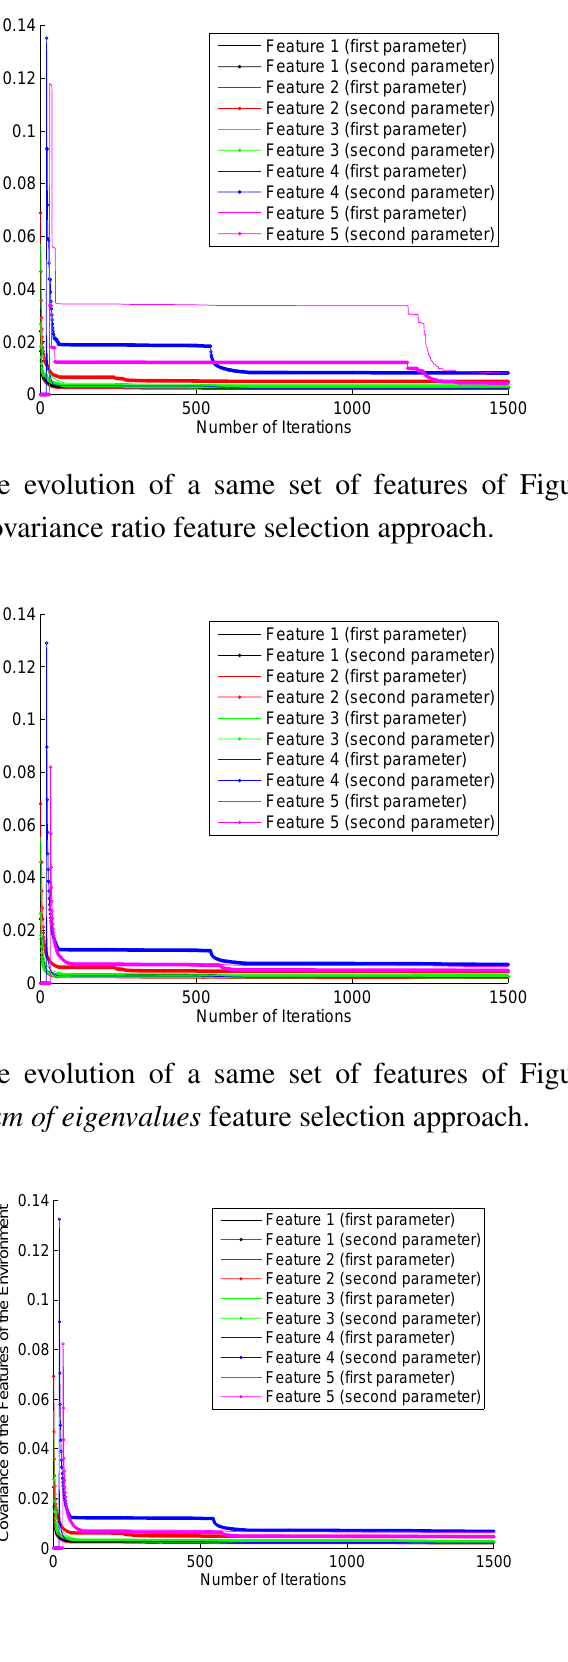
Figure 13. Covariance evolution of a same set of features of Figure 12 estimated by EKF-SLAM with the entropy feature selection approach.